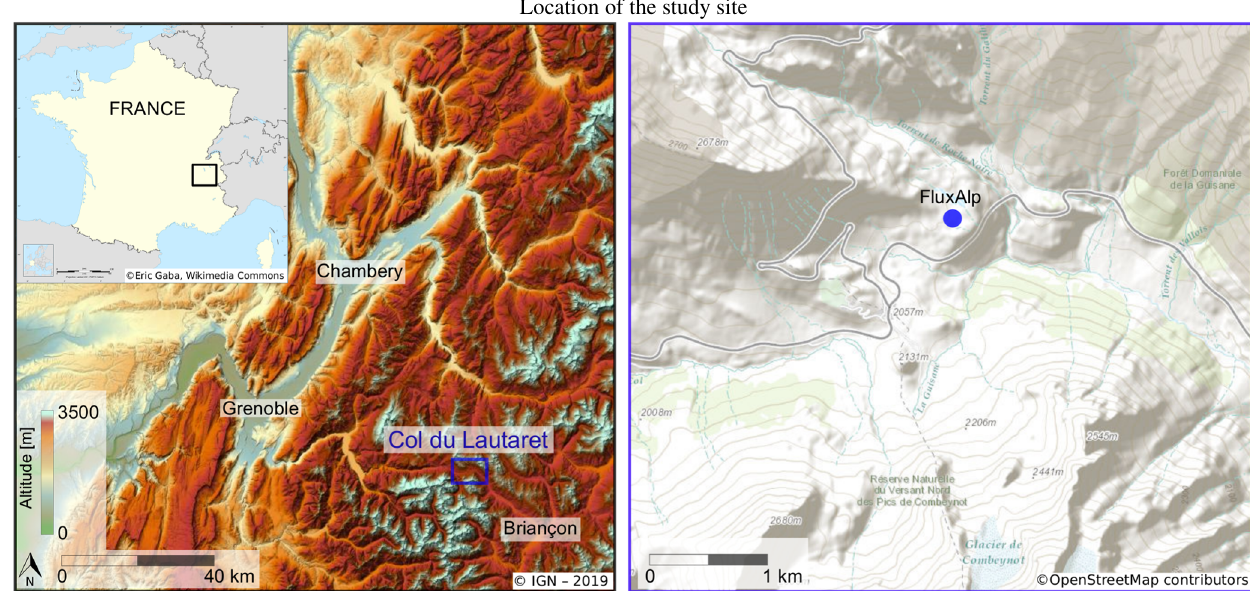
Figure 1. Localisation of the study area. The left panel shows the Col du Lautaret site on a hillshade superimposed on the 25m digital elevation model (DEM) produced by the French National Institute of Geographic and Forest Information (IGN). The right panel shows the automated weather station superimposed on the OpenStreetMap product, © OpenStreetMap contributors 2019. Distributed under a Creative Commons BY-SA